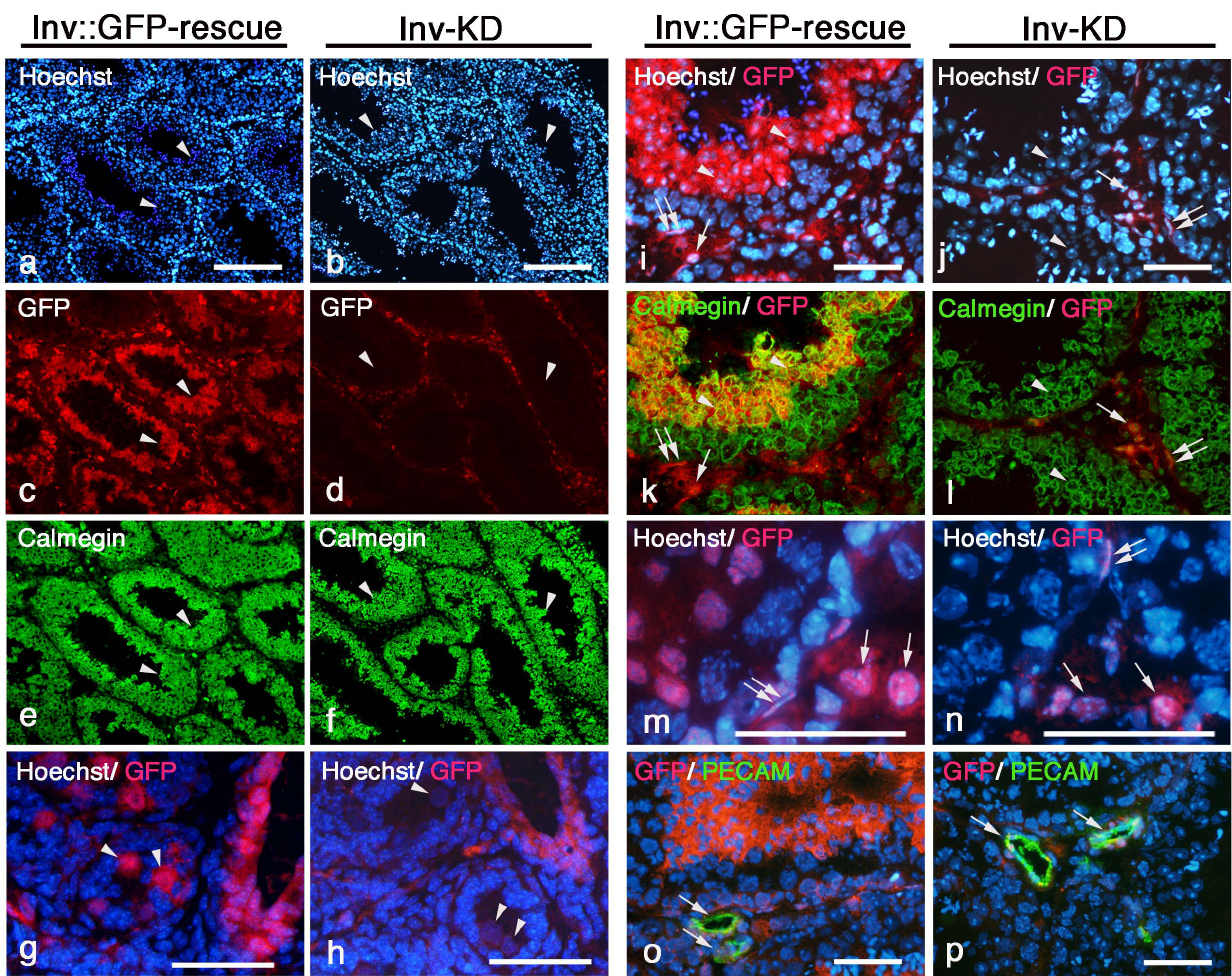
Figure 5. Testicular germ cell-specific elimination of Inv::GFP protein in Inv-KD mice. Testicular sections prepared from adult (a–f and i–p) or postnatal (3 day) (g and h) Inv-KD mice (b, d, f, h, j, l, n and p) or control Inv::GFP-rescue mice (a, c, e, g, i, k, m and o) were stained with anti-GFP antibodies (g, h, m and n, red) or double-stained with anti-GFP antibodies (c, d, i–l, o and p, red) and testicular germ cell-specific anti-calmegin antibodies (e, f, k and l, green) or vascular endothelial cell-specific PECAM-1 antibodies (o and p, green). Hoechst-stained images are shown to identify the cell types of the testis (a, b, g–i and m–p, blue). Inv::GFP protein was mainly observed in the spermatid cells of testicular germ cells (a, c, e, i and k, arrowhead) and somatic cells, such as connective tissue cells and Leydig cells (m, double arrows and arrow) and vascular endothelial cells (o, arrow)